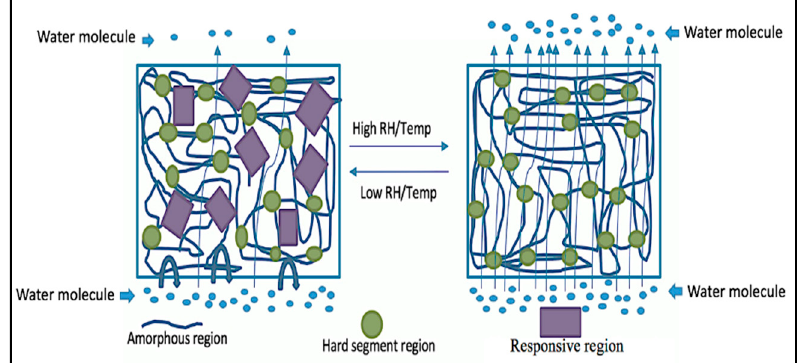
Figure 8. Molecular structure design of responsive polyurethane. Polymers 2018 , 10 , x FOR PEER REVIEW